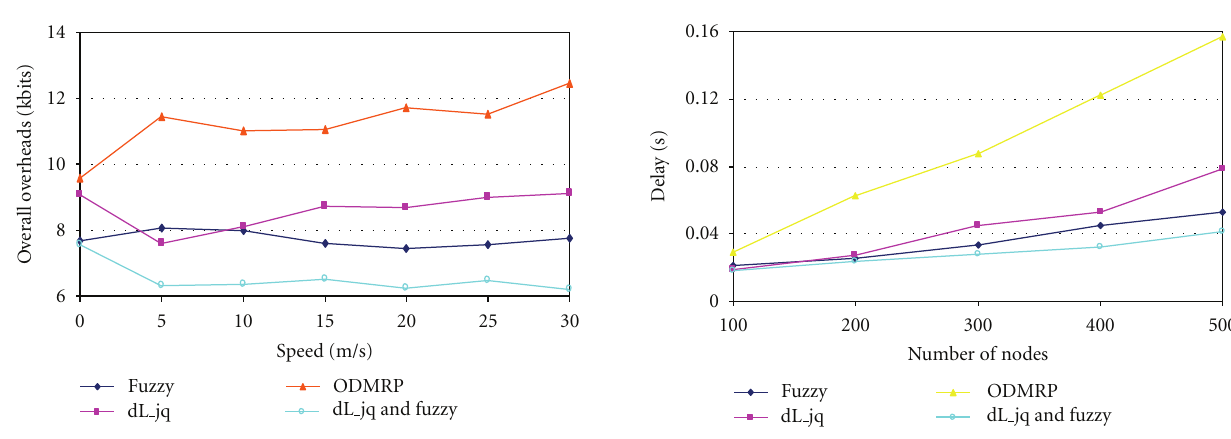
Figure 12: End to end delay with increasing number of nodes.